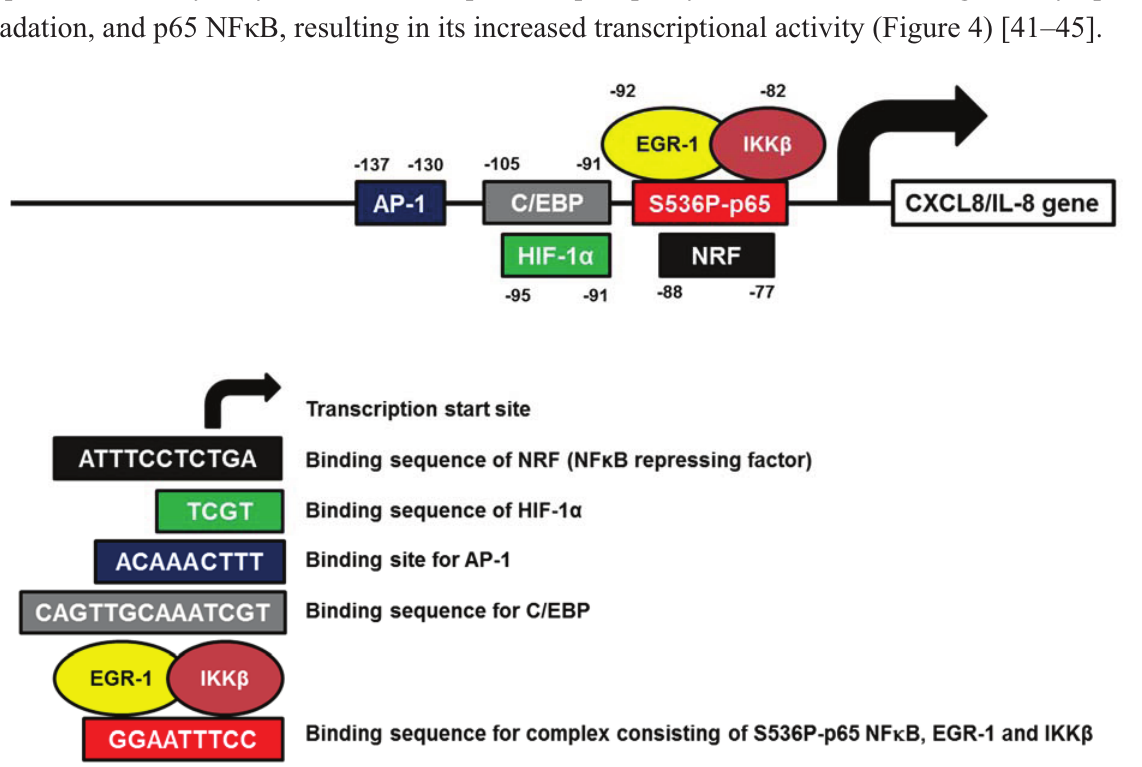
Figure 4. Human CXCL8 promoter with the identified transcription factor binding